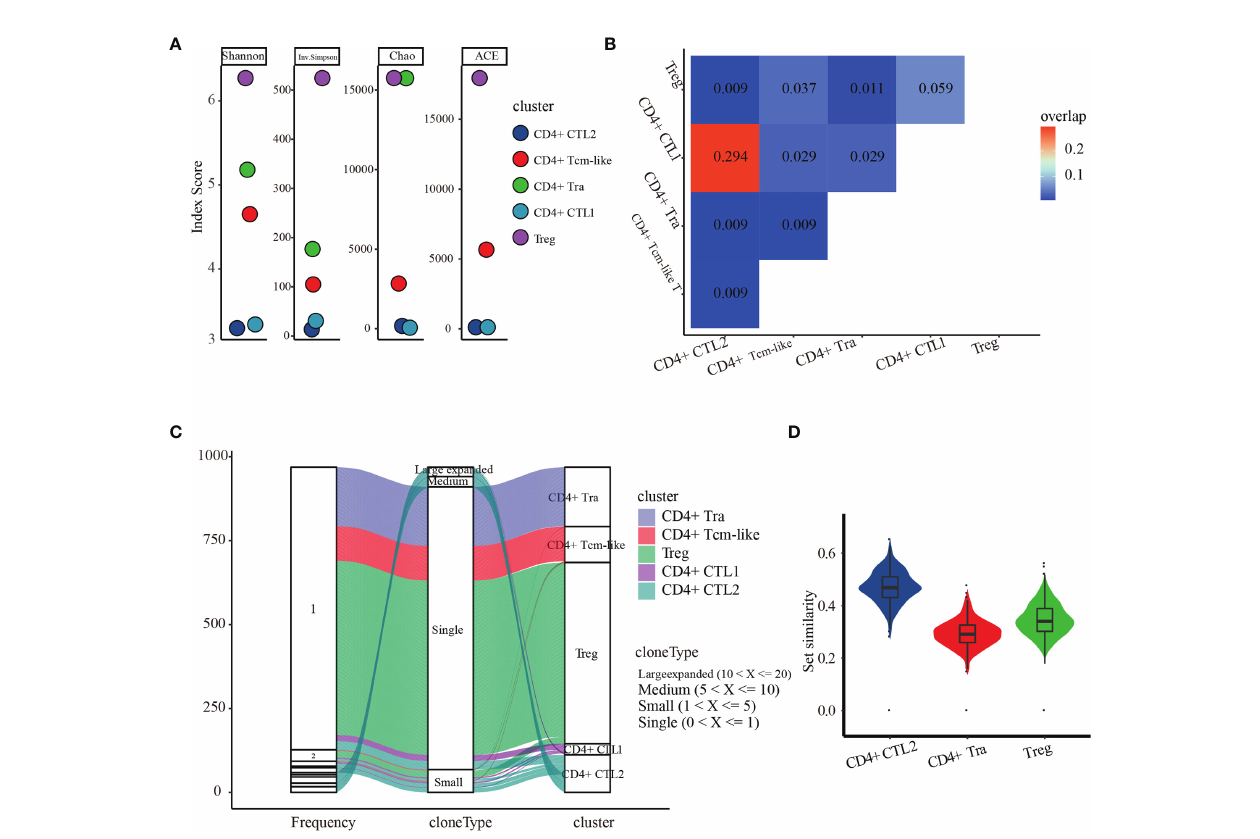
FIGURE 5 | TCR repertoire analysis of the fi ve CMV CD4+ T cell subsets. (A) Diversity measures based on clonotypes by cluster using Shannon, Inverse Simpson, Chao, and abundance-based coverage estimator (ACE) indices. (B) Clonal overlaps among the fi ve CMV CD4+ T cell subsets. (C) Cloning frequency distribution in each subset. (D) Transcriptome similarity among CMV CD4+ CTLs, CD4+ Tra cells, and Treg